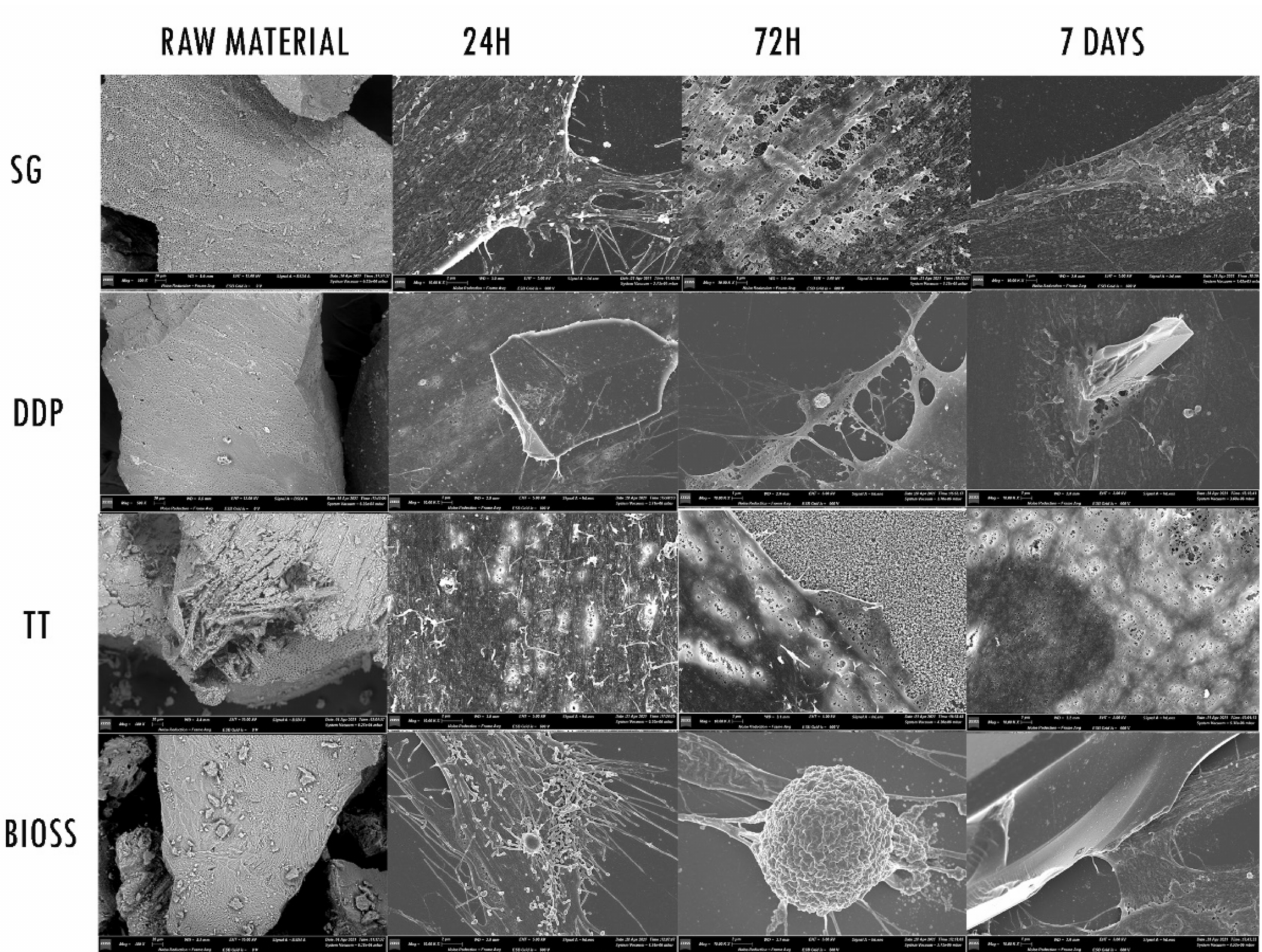
Figure 3. SEM images. The first column on the right shows the SEM of the different Raw Materials. Magnification 200 × . The other columns show the different reaction of the fibroblasts when exposed to the experimental materials SG, DDP, and TT and the positive control BIOS, at 24 h, 72 h and 7 days. Magnification 1000 ×